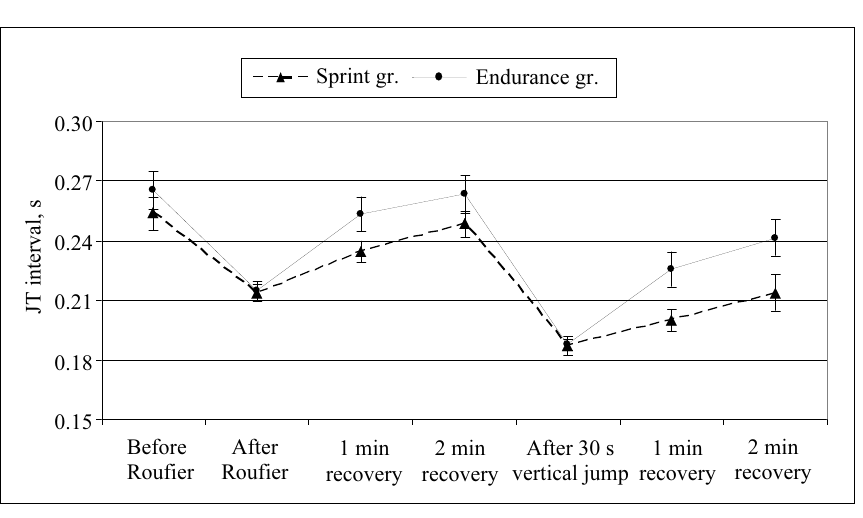
Figure 2. Dynamics of JT interval during dosed and maximal exercise test